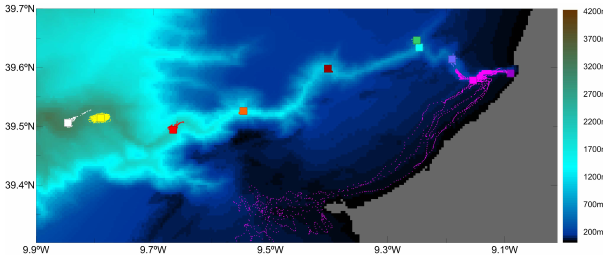
Fig. 7. Snapshot of the 4000µm OMA dispersion patterns after 22days of